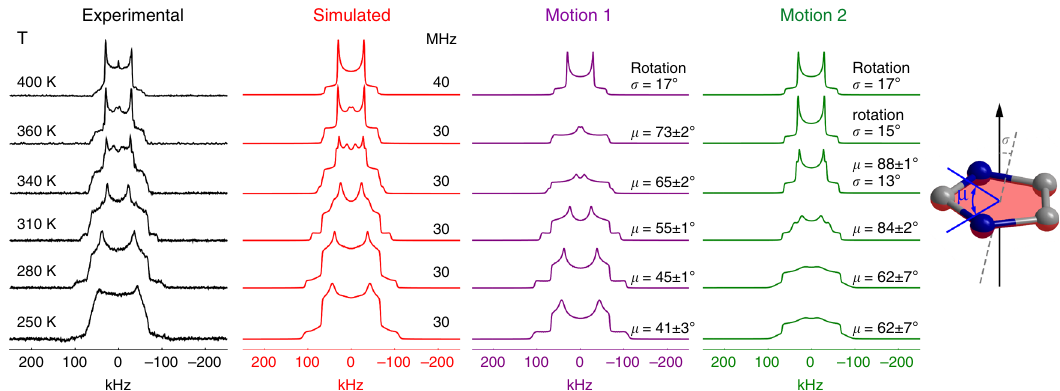
Fig. 4 2 H solid-state NMR spectra of deuterated Himd + cations at various temperatures. The black and red lines represent the experimental spectra and the simulation results, respectively. According to the simulation results, the 2 H pattern at each temperature can be deconvoluted into two components with an intensity ratio of 6:4. The motions 1 (purple line) and 2 (green line) should correspond to the different dynamic modes of the Himd + cations in layers A and B, respectively. The molecular structure depicts the thermodynamic motion of Himd + , where μ is the mean amplitude of the in-plane wobbling angle around molecular C 5 -axis and σ is the out-of-plane